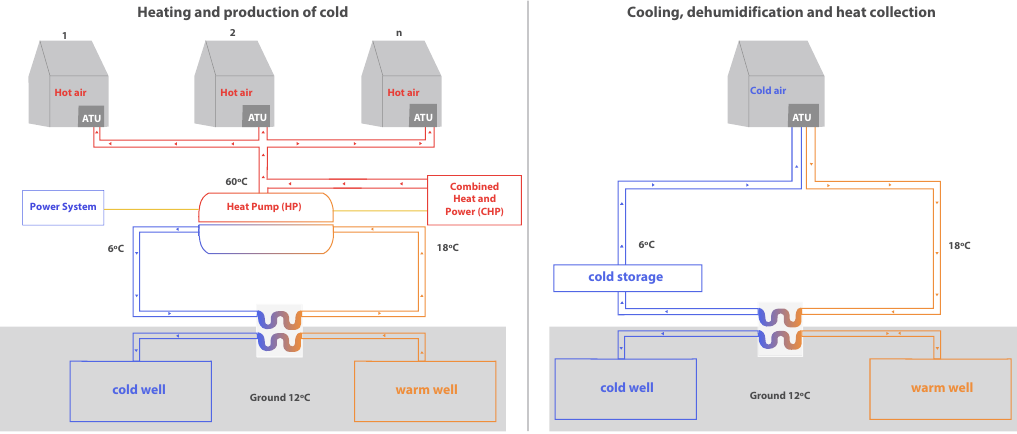
Figure 1. Energy Recovery Infrastructure